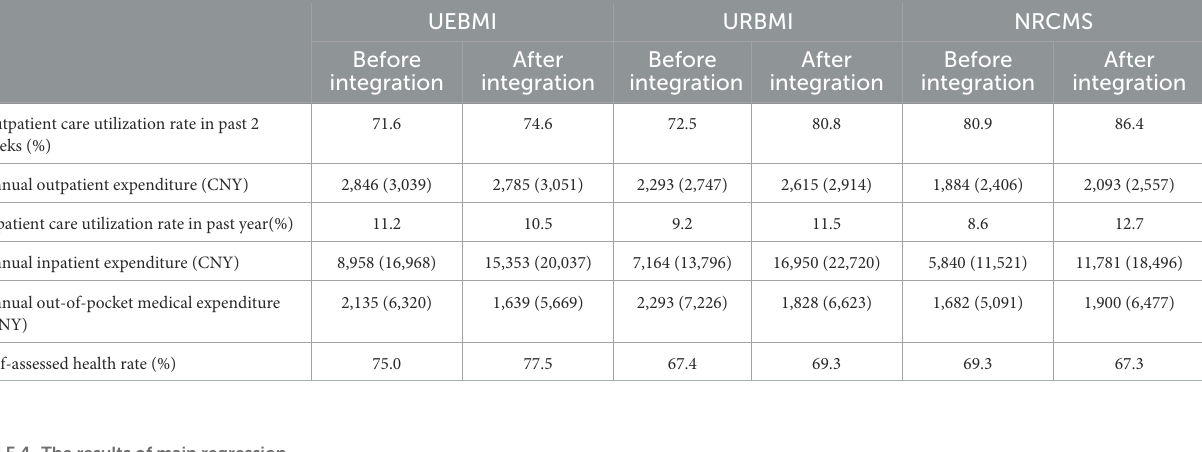
TABLE 4 The results of main